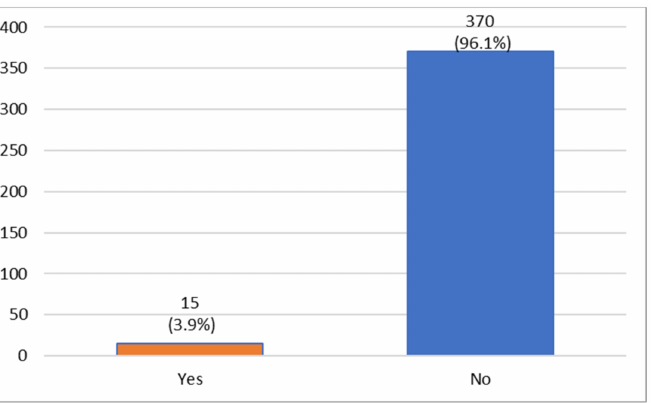
Figure 9. Distribution of adult according to the adoption or not exclusively vegetarian diet in